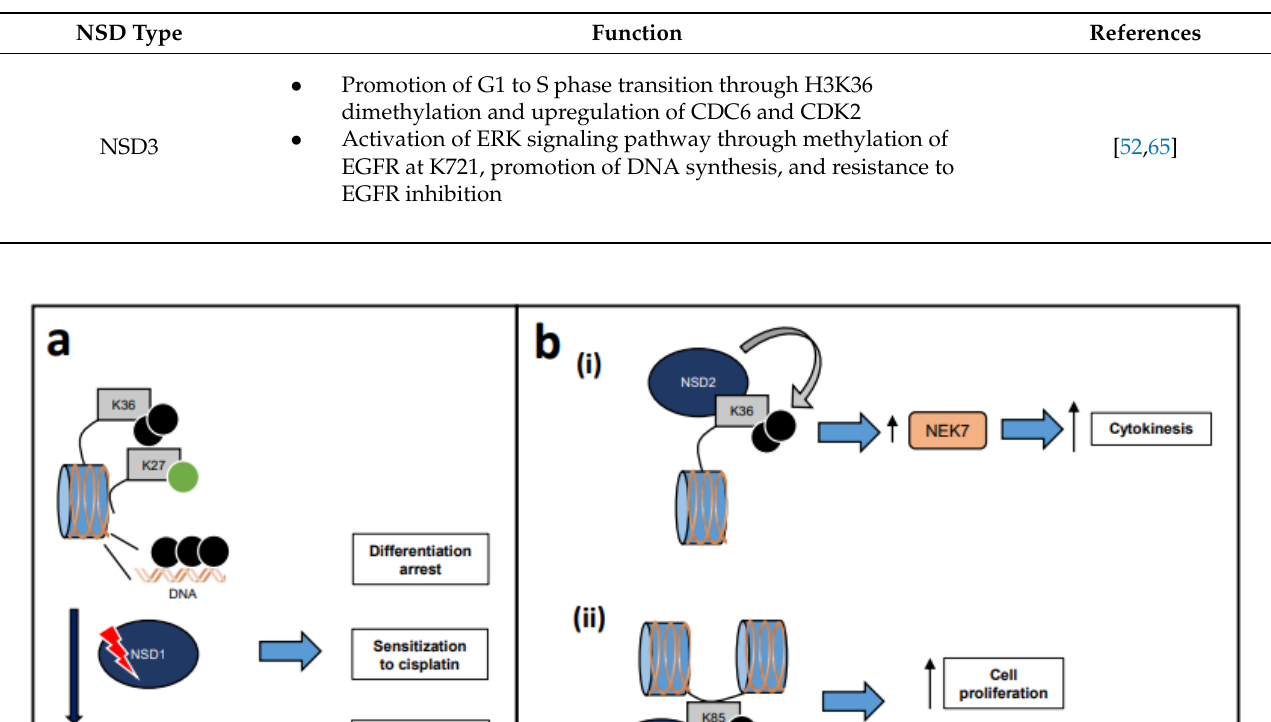
Table 2. Function of NSDs in HPV-negative HNSCC.